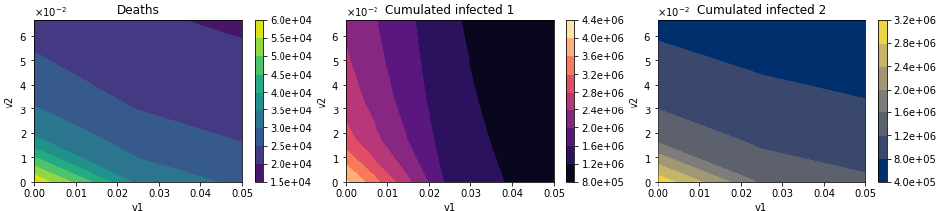
Figure 5. Number of deaths and infected individuals from the two different age groups. This scenario considers that the transmission rate of people in the 55+ age group is half of the transmission rate of 15–54 years-old. Vaccine efficacy is assumed 90%, v 1 = 0.05 and v 2 = 0.01.